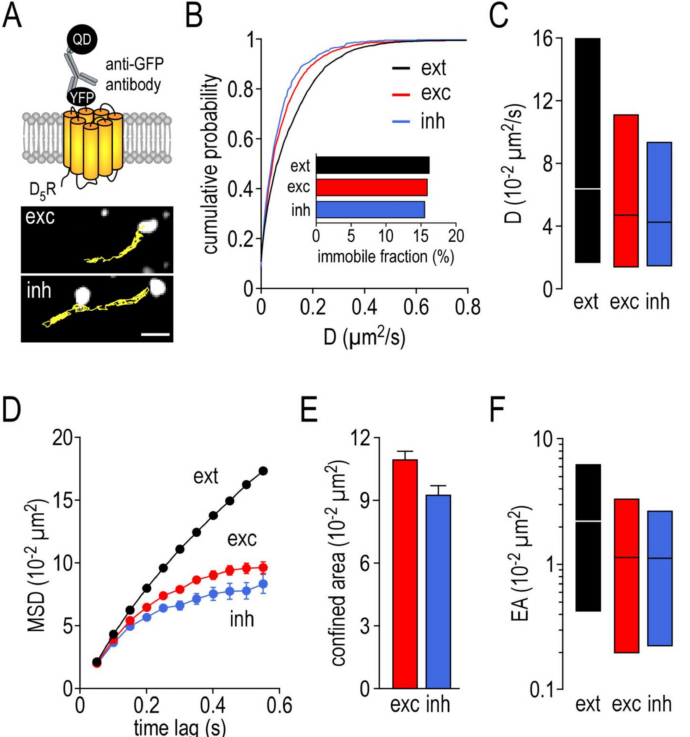
Figure 7. The surface dynamic properties of dopamine D5 receptors are not differentially altered at excitatory or inhibitory synapses. ( A ) Cartoon showing the experimental design (upper panel) and examples of trajectories of a single dopamine D5 receptor–YFP–anti-GFP antibody–QD complex (500 frames, 50 ms acquisition) on the dendritic shaft with either identified excitatory (exc) or inhibitory (inh) synaptic areas (lower panel). Scale bar, 350 nm. ( B ) Cumulative probability diffusion coefficient of dopamine D5 receptors at inh or exc synapses compared to extrasynaptic area (ext). The inset shows the immobile fraction (defined as D < 0.005 µ m 2 /s) in the different areas. ( C ) Bar graphs illustrating the instantaneous diffusion coefficient (D, represented as median ± interquartile range 25–75%) of dopamine D5 receptors in ext, exc and inh areas. ( D ) Comparison of dopamine D5 receptors mean square displacements (MSD, represented as mean ± SEM) in ext, exc and inh areas. ( E ) Bar graphs illustrating the confined area (for the time period 250–550 ms and represented as mean ± SEM) of dopamine D5 receptors in exc and inh areas. ( F ) Bar graphs illustrating the explored surface area (EA, represented as median ± interquartile range 25–75%) of dopamine D5 receptors in ext, exc and inh